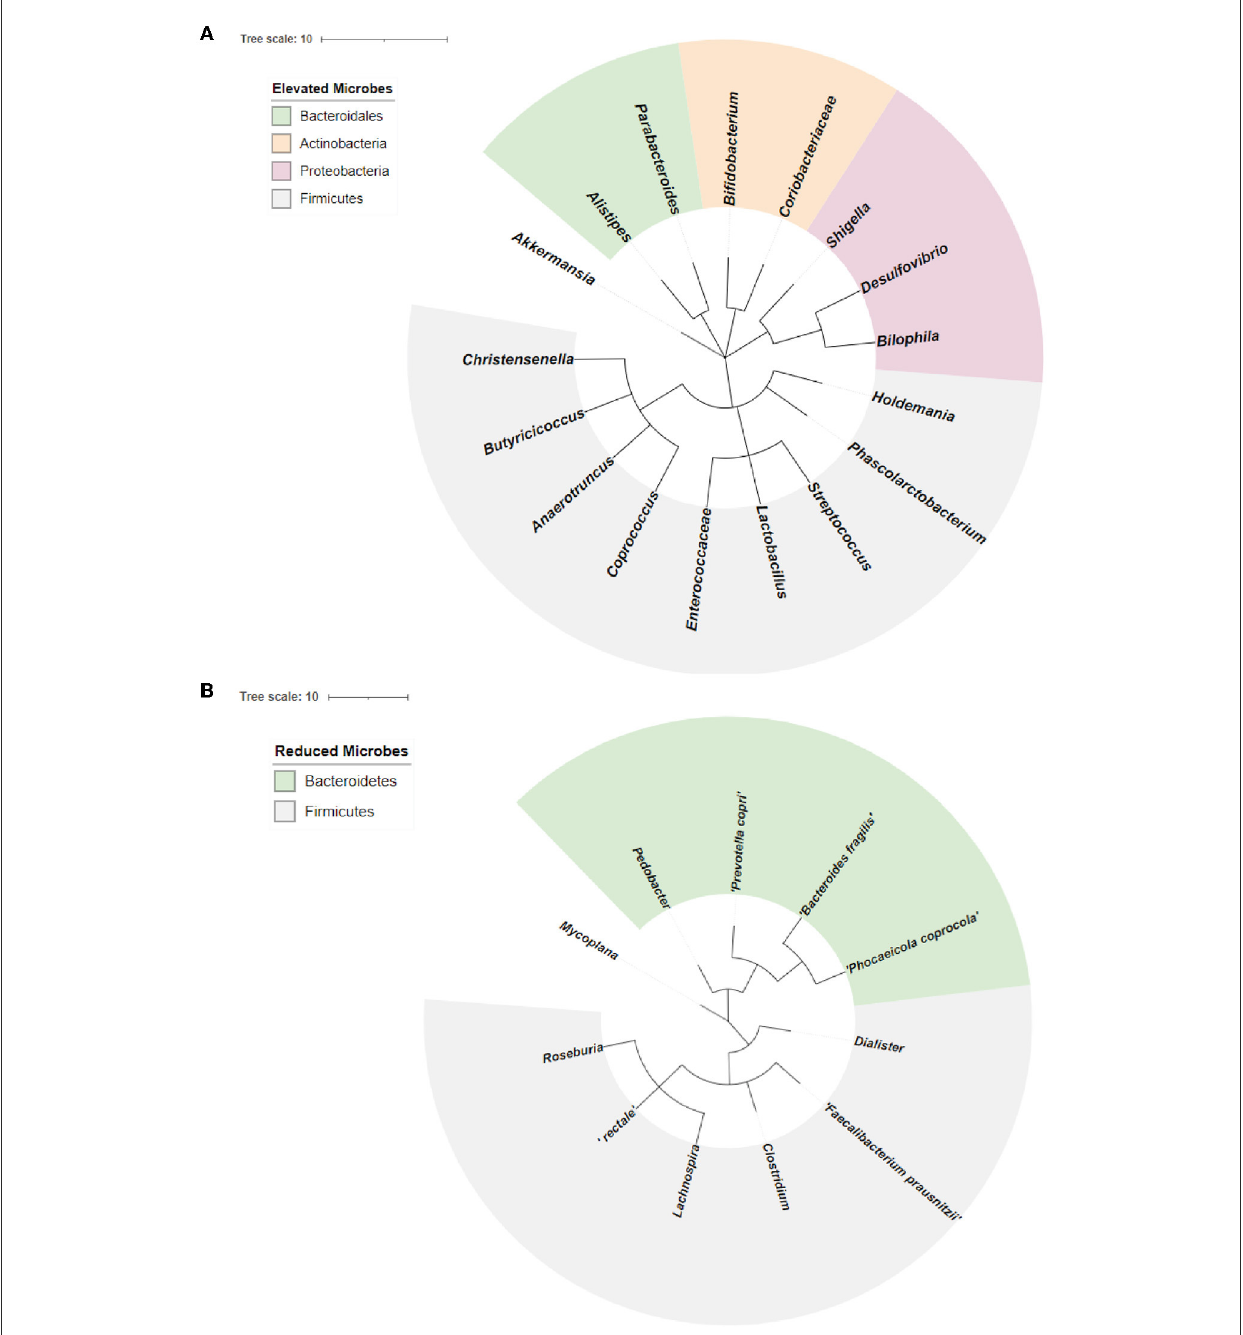
FIGURE4 Phylogenetic analysis of overlapping microbial dysbiosis in diseases including AD, PD, MS, and ALS. (A) Phylogenetic tree of common microbes with the elevated population in AD, PD, MS, and ALS. (B) Phylogenetic tree of common microbes with the reduced population in AD, PD, MS, and